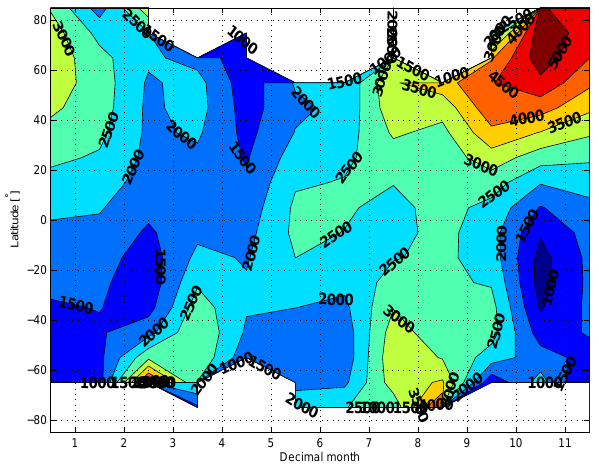
Fig. 13. Peak concentration of mesospheric sodium [atoms/cm − 3 ] as a function of time and latitude.